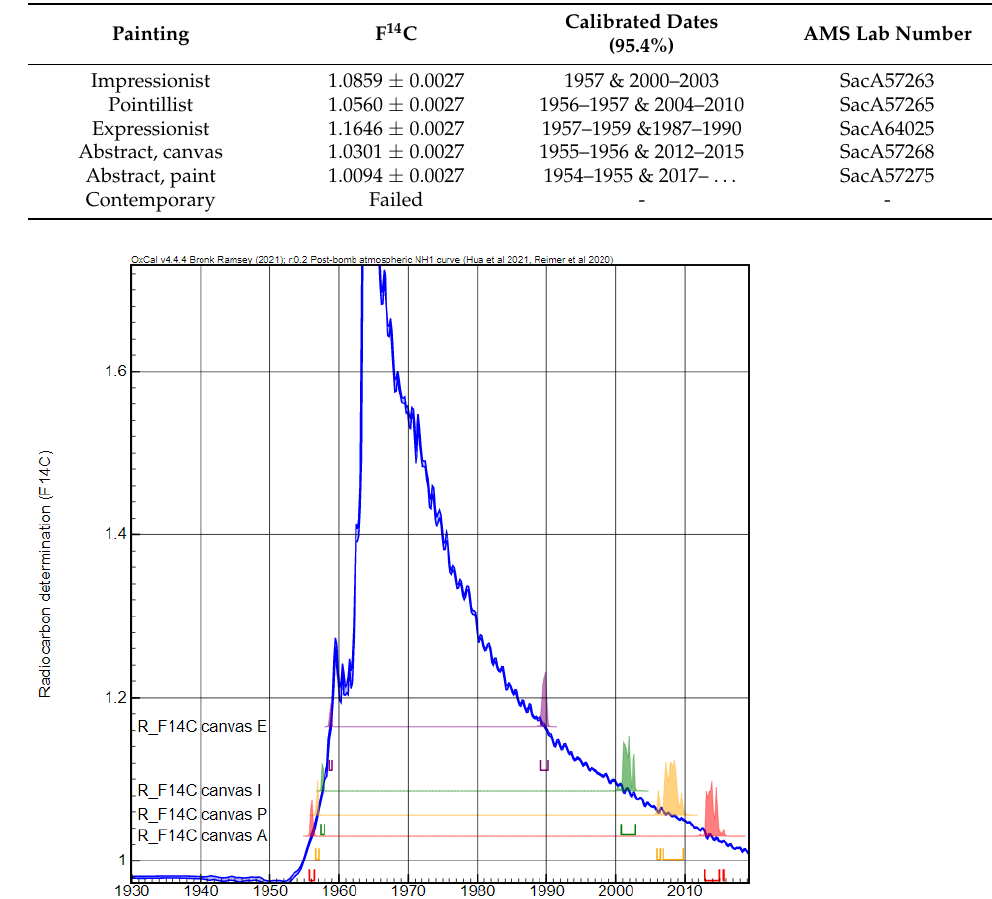
Table 4. 14 C Fraction Modern (F 14 C) results for the fibers taken from the painting canvases and for a sample of paint taken from the white paint of the Abstract painting. F 14 C is the unit used for post- bomb samples. Radiocarbon dates were calibrated using the Bomb13 NH1 post-bomb atmospheric curve [27] (Figure 8). See text for details.